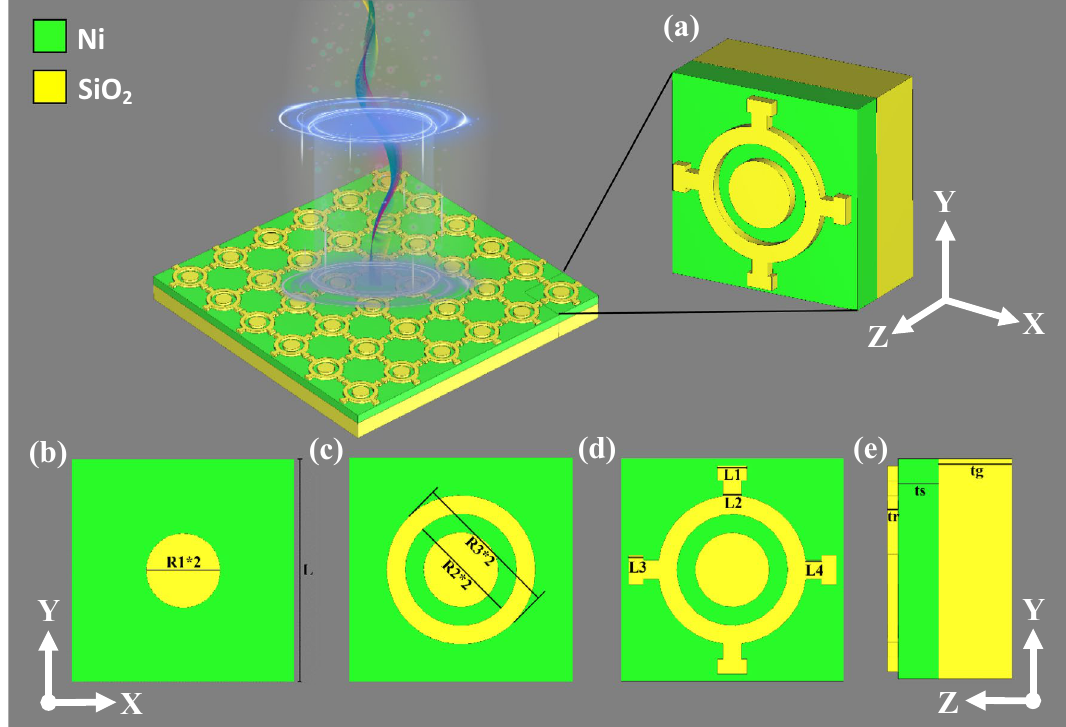
Figure 1. Design evaluation of the unit cell structure ( a ) circular shape added with the radius of R1, ( b ) ring added with inner radius R2 and outer radius R3, ( c ) Proposed unit cell in front view in y–x axis, ( d ) dimensions in side view in y–z axis, and ( e ) proposed unit cell in perspective view.